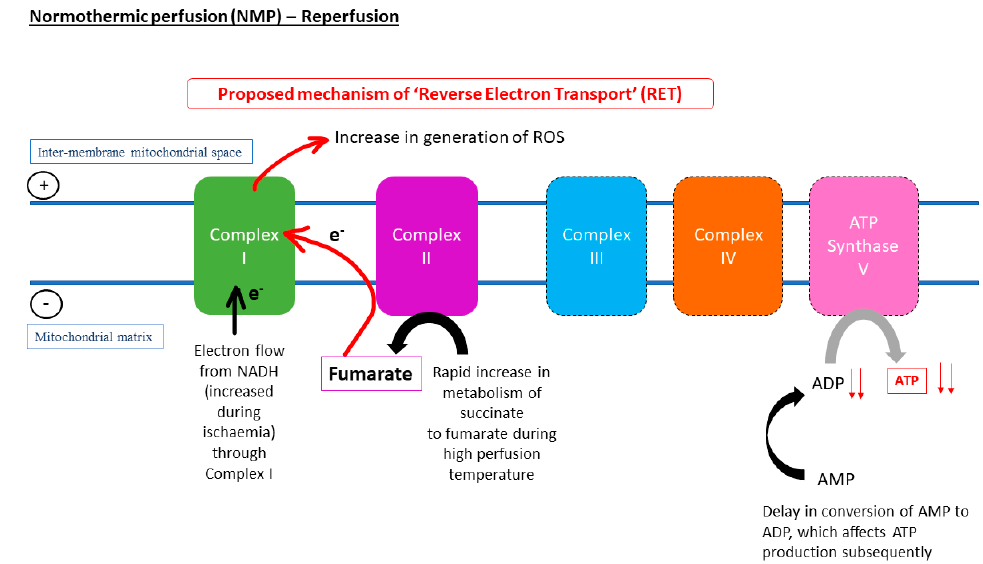
Figure 3. The increase in metabolism of succinate upon restoration of oxygen during reperfusion might lead to reverse electron transport (RET), absence of electron flow to ATP synthase, and delay in conversion of AMP to ATP. Thus, ADP production might lead to a decline in ATP production. Following from this, in the liver, the absence of ADP due to ischaemia and the high temperature during normothermic machine perfusion (NMP) could increase the metabolism of succinate to fumarate, leading to an increase in the flow of electrons through Complex I, which hastened generation of ROS underlying reperfusion